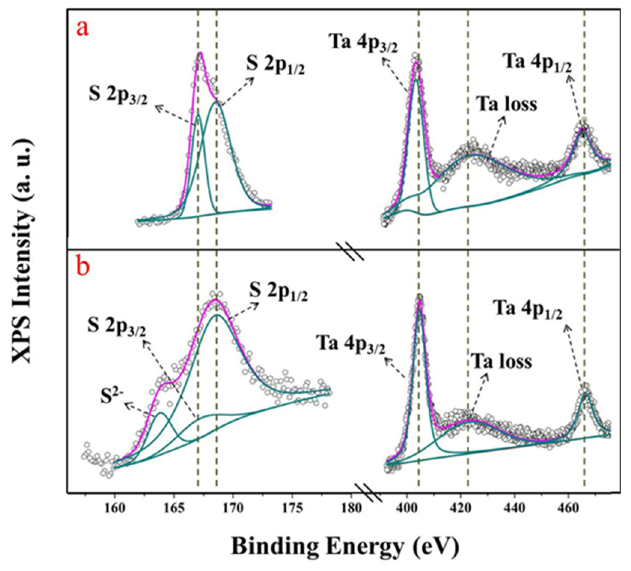
Figure 6. ( a ) XPS spectra of bulk TaS 2 ; ( b ) XPS spectra of TaS 2 nanoflakes.